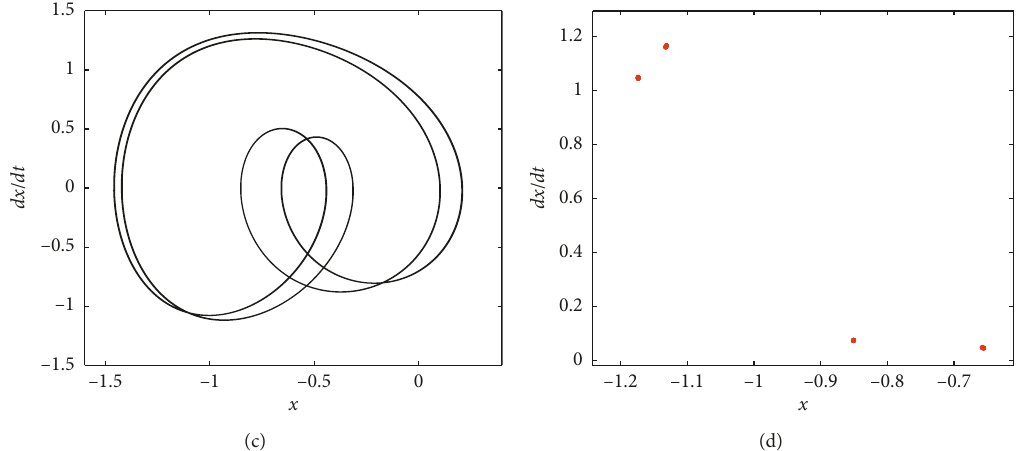
Figure 12: System response at ω � 1.95rad/s and F � 1.5N: (a) time history; (b) frequency spectrogram; (c) phase portrait; (d) Poincare maps.